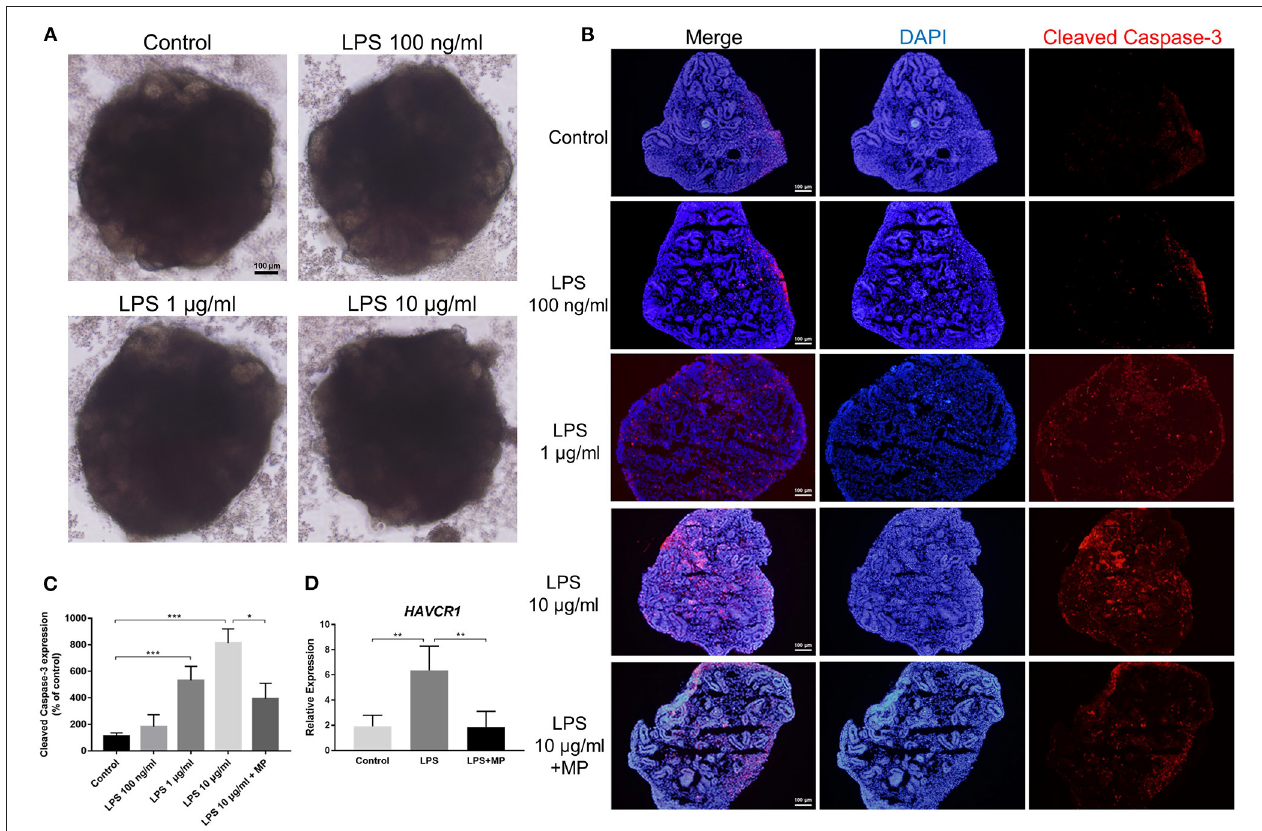
FIGURE 4 | LPS does not alter the structure but induces apoptosis in kidney organoids. (A) Different concentrations of LPS caused no morphological changes in kidney organoids. (B) LPS induced apoptosis in kidney organoids in a dose-dependent manner and was alleviated by MP treatment. Kidney organoids were stained with cleaved Caspase-3 (Red) and DAPI (Blue). (C) Corresponding semi-quantitative analysis of cleaved Caspase-3. (D) Quantitative PCR analysis of the AKI marker HAVCR1. Scar bar = 100 µ m. * P < 0.05, ** P < 0.01, *** P <